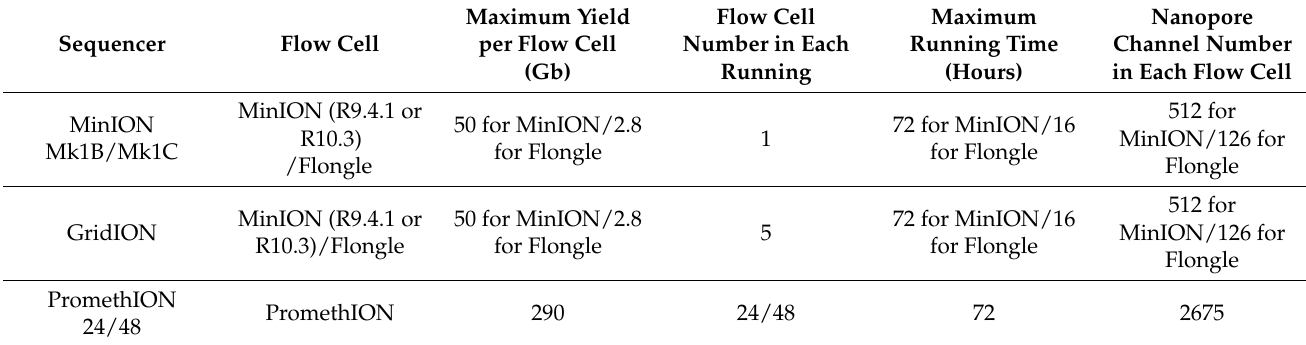
Figure 1. Schematic diagram of nanopore sequencing technology. ( A ). Double-stranded DNA is unwound by a motor protein. One strand of DNA is passed through a nanopore protein that forms a channel in an artificial membrane to which an ionic current has been applied. The ion current is altered depending on the identity of the base passing through the channel. The resulting fluctuations are decoded and translated to DNA (or RNA) sequence. ( B ). Inny and outy sequencing modes. Adapted from “Nanopore Sequencing”, by BioRender.com (2021). Retrieved from https: //app.biorender.com/biorender-templates (accessed 15 September 2021). Table 1. General properties of commercial nanopore sequencer machines and their flow